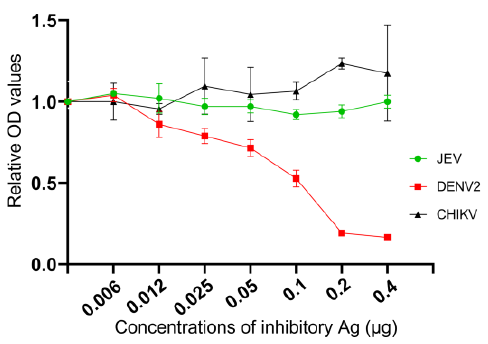
Figure 5. The comparison of the relative OD values obtained using the NS1 ELISA for DENV infected serum sample that was inhibited by R-DENV2-NS1 antigen, JEV antigen and CHIKV antigens in different for cross reaction among anti-DENV IgG, anti-JEV IgG and anti-CHIKV IgG antibodies in the NS1 ELISA. The OD values indicated with triangle markers and error bars were results of serum sample that was absorbed with CHIKV antigen after preincubated, whereas dot markers and error bars were result of serum sample that was absorbed with JEV antigen and while square markers and error bars was absorbed with R-DENV2-NS1 antigen, which were used as primary antibody in inhibitory test.